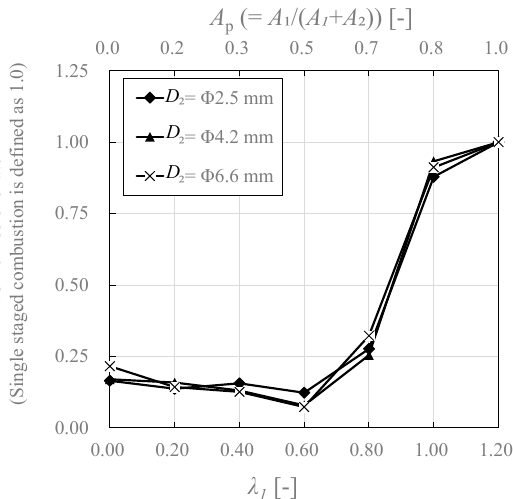
Figure 3. Comparison of NOx emissions rates for different λ 1 . Input = 11.63 kW, λ total = 1.2, E NH3 = 10%, L = 100 mm.